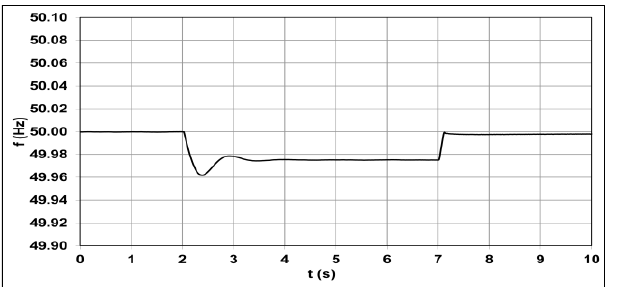
Figure 10. Frequency changes in the receiving node, resulting from the operation of the farm in the frequency regulation mode. frequency regulation